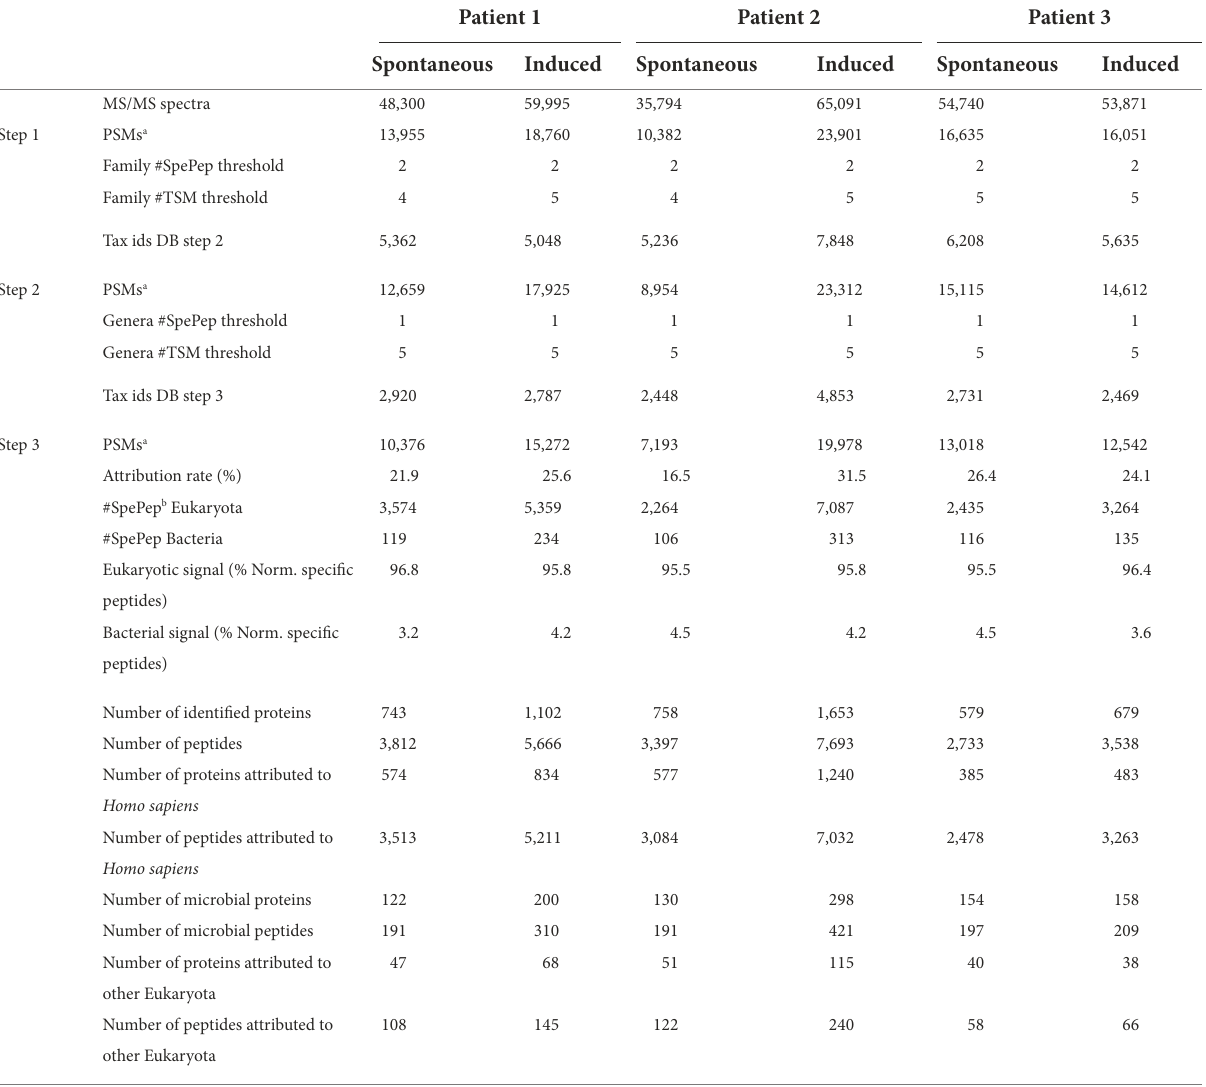
TABLE 1 Metaproteomic data of spontaneous versus induced sputum samples using a mass-exclusion list strategy by